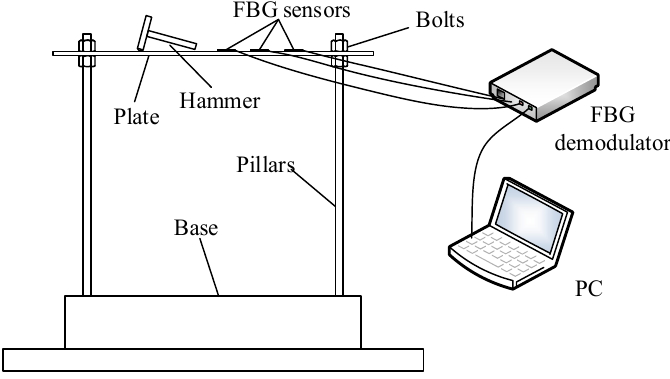
Figure 5. Setup of the experimental system.